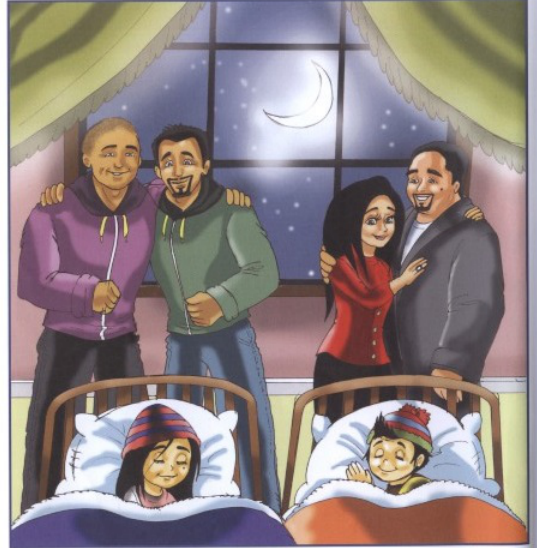
Figure 12. The bedtime story has reached its end.